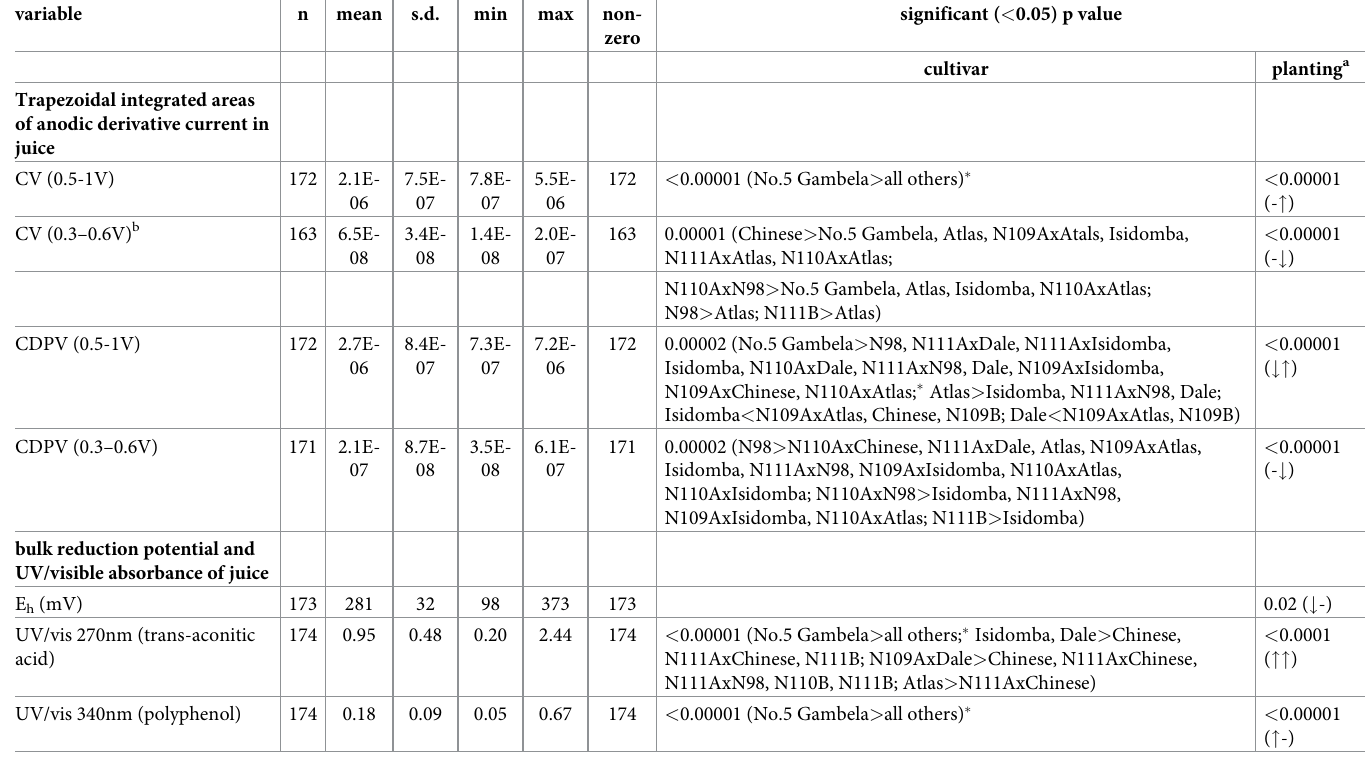
Table 1. Trapezoidal integration of major (0.5–1 V) and minor (0.3–0.6 V) anodic CV, CDPV peaks; E h in mV; and UV/visible absorbance at wavelengths attribut- able to trans-aconitic acid and polyphenol [8]. Only significantly different p-value ( < 0.05) are given for the cultivar and planting month effects with post-hoc Tukey’s HSD test. Total number of samples (n for 24 cultivars × planting months (April, May, and June of 2017) × triplicate field plots), mean, standard deviation (s.d.), minimum, maximum, and number of non-zero values for each variable. Cultivar × planting interaction was observed only for the UV/visible absorbance at 270 nm (p = 0.02).